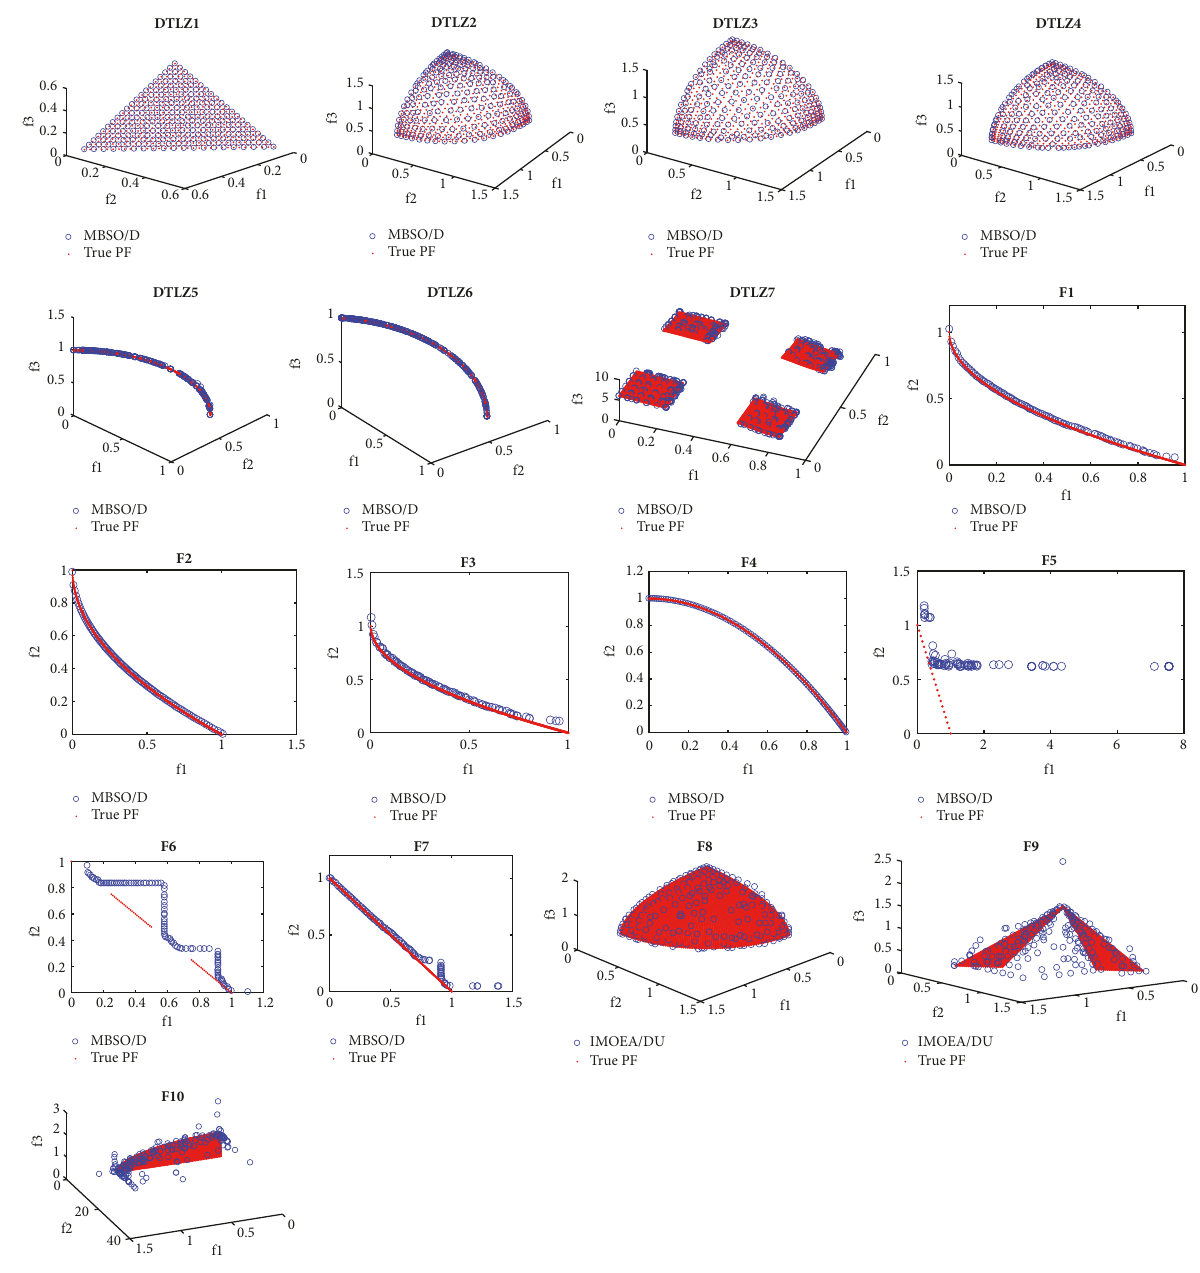
Figure 1: According to the median values of IGD metric, nondominated solutions obtained by MBSO/D on seven DTLZ problems and ten F1-F10